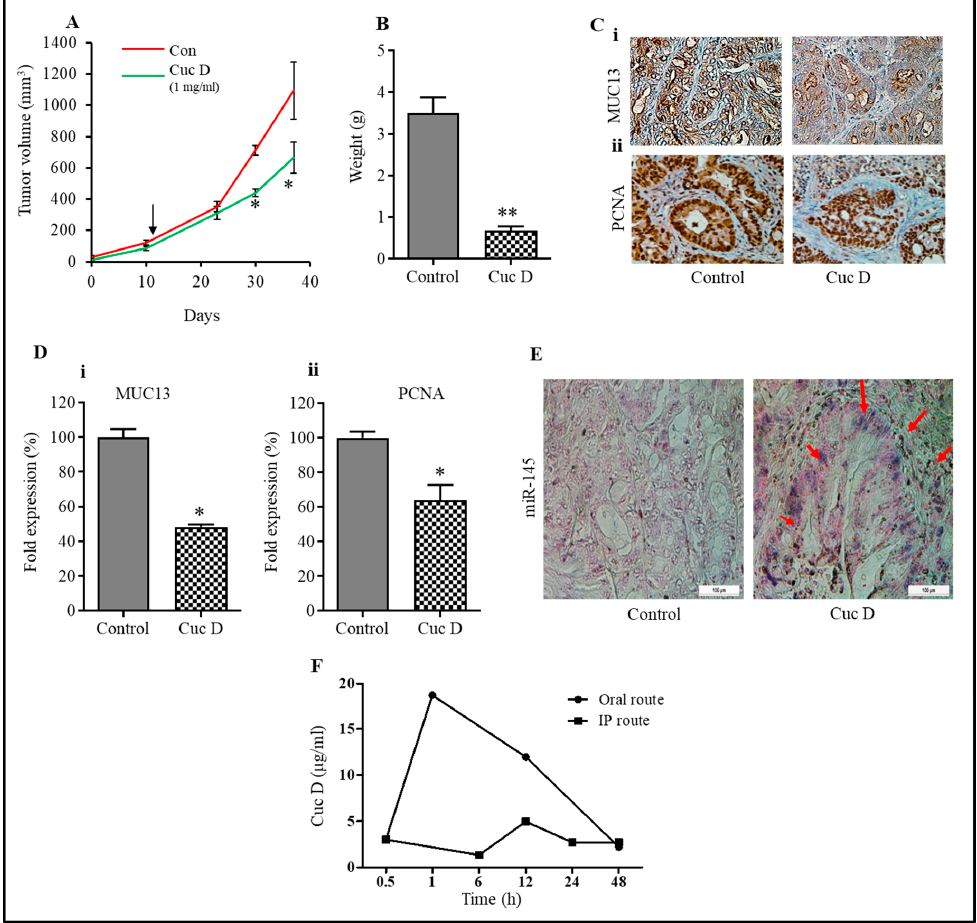
Figure 6. Effect of Cuc D on growth of HPAF-II cells derived xenograft mouse model. ( A ) Line graph indicates regression of HPAF-II cell-derived xenograft tumor volume in Cuc D treated mice compared to control group. Values in bar graph represent mean ± SE of six mice tumors in each group. Asterisk (*) denotes the significant value p < 0.05. ( B ) Tumor weight of control and Cuc D treated mice. Asterisk (**) denotes the significant value p < 0.01. ( C ) Effects of Cuc D on the expression of MUC13 ( Ci ) and PCNA ( Cii ) in excised xenograft tumor tissues of control and Cuc D treated mice as determined by immunohistochemistry ( D ) Representative images were captured at 20× magnification. Bar graphs represent quantification of immunohistochemistry images of MUC13 ( Di ) and PCNA ( Dii ). Student’s t-test was performed to analyze significant difference. Asterisk (*) denotes the significant value p < 0.05. ( E ) The effect of Cuc D on the expression of miR-145 in control and treated mice excised tumors, as determined by in situ hybridization (magnification, ×20). ( F ) Pharmacokinetics studies of Cuc D (2 mg/kg bw) in mice by oral and i.p. route.